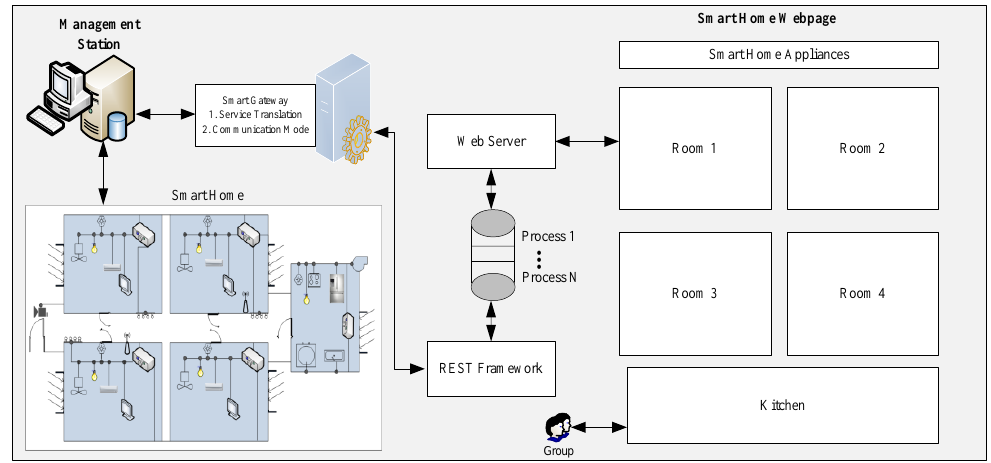
Figure 1. Proposed smart home architecture based on WoT-ESN.